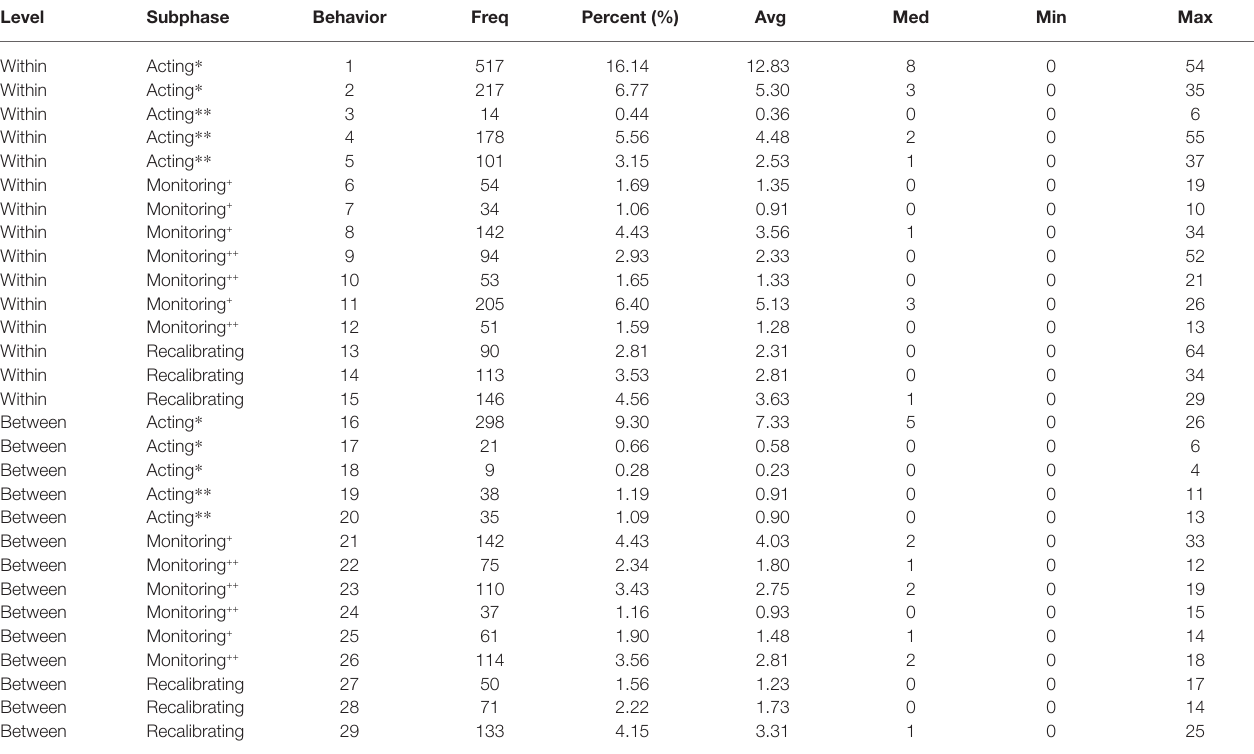
TABLE 3 | Frequencies of Occurred Codes across the